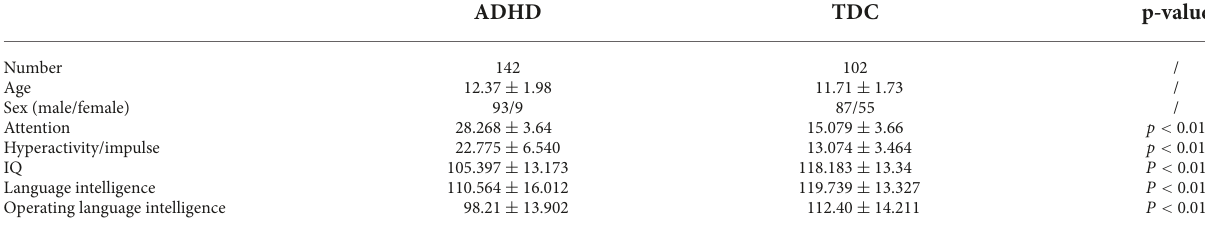
TABLE 1 Demographic and clinical characteristics of the ADHD and TDC